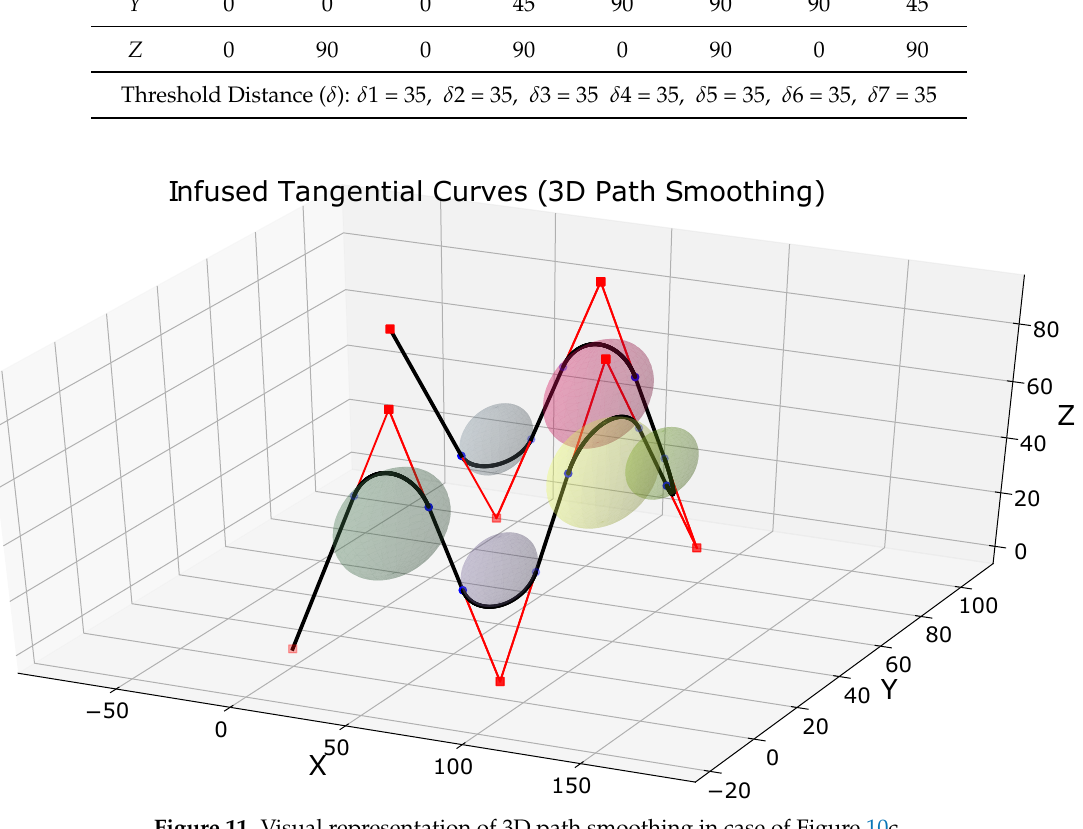
Figure 11. Visual representation of 3D path smoothing in case of Figure